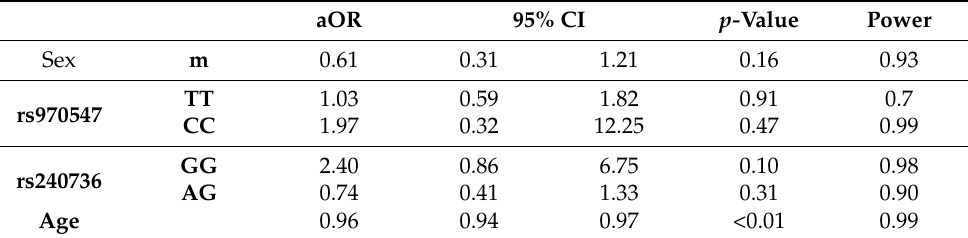
Table 3. Multivariable, sex, and age-adjusted logistic regression modeling for COL12A1